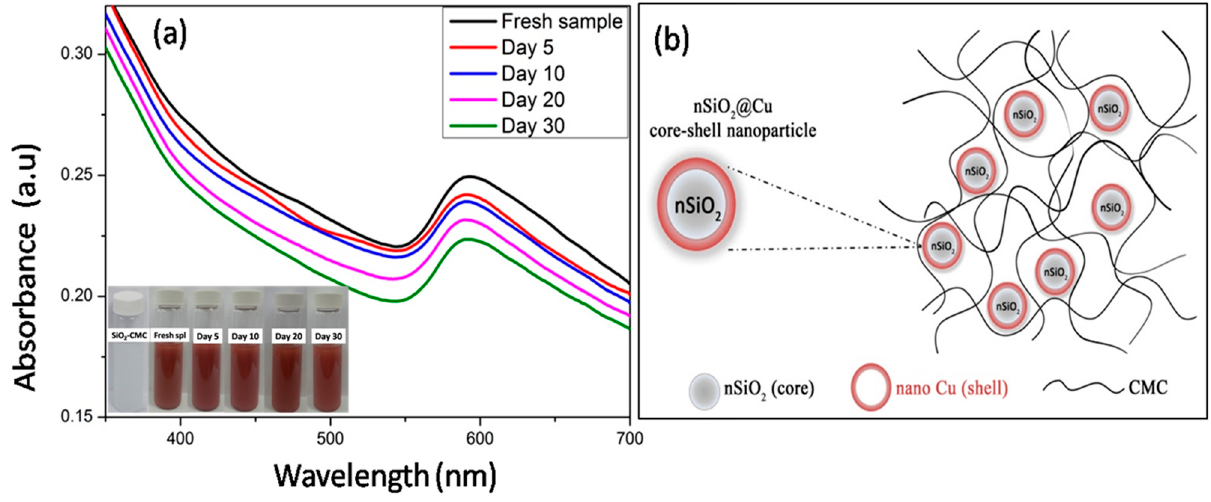
Figure 1. UV-vis absorption spectra of the as-prepared colloidal solutions as a function of time ( a ) and the scheme of SiO 2 @Cu@CMC nanoparticles (NPs) ( b ).